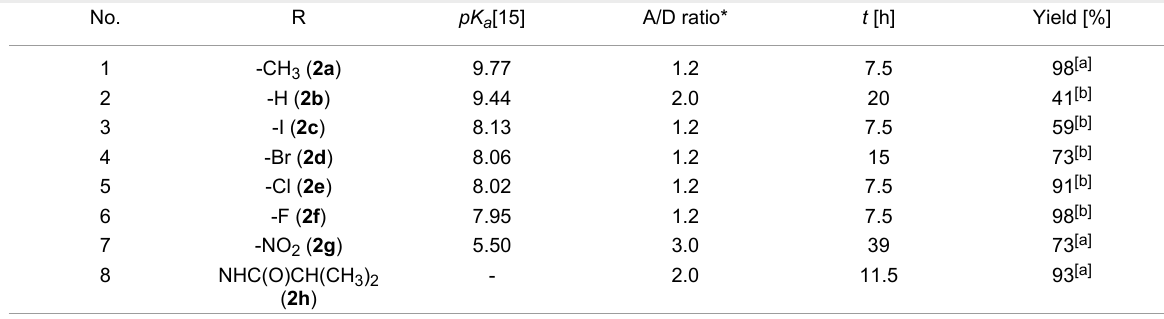
Table 1: Conditions for the Michael-type addition of 5-substituted uracil derivatives to 2-hydroxyethyl acrylate